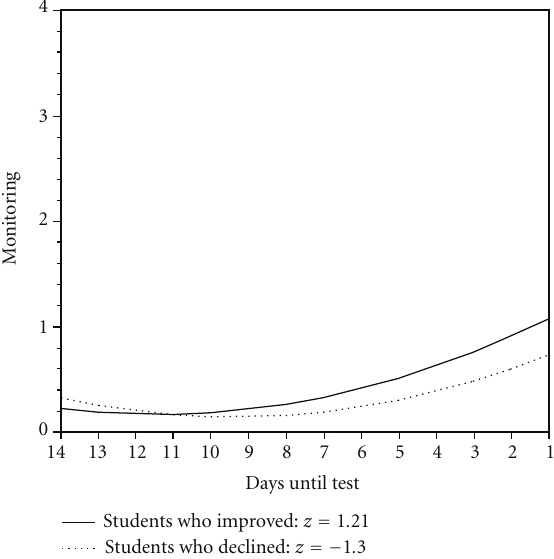
Figure 5: Change in frequency of monitoring strategy use by improvement classification. Note: The two lines reflect the growth curves of the parameters for averaged lower and upper quartiles considering the relative improvement between the two